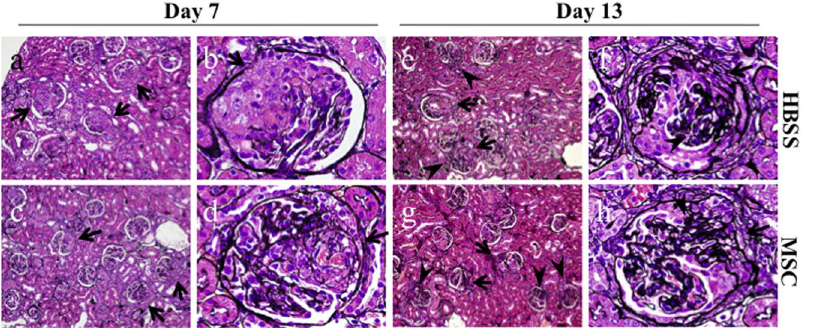
Figure 2. Light microscopic findings in the study groups. Representative pictures stained with silver on day 7 ( a – d ) and day 13 ( e – h ) in an HBSS-treated rat with nephritis ( a, b, e, f ) and an MSC-treated rat with nephritis ( c, d, g, h ). The glomeruli on day 7 show severe fibrinoid necrosis and cellular crescent formation (arrows) ( a, b ). The crescentic glomeruli have started to transform from cellular to fibrocellular (arrows), and there is some segmental glomerulosclerosis (arrowheads) on day 13 ( e, f ). hMSC treatment reduces glomerular hypertrophy on day 7 ( c, d ) and day 13 ( g, h ). hMSC treatment also reduces crescent formation on day 13 ( g, h ). Original magnifications, x200 (a, c, e, g), x1000 (b, d, f, h). doi:10.1371/journal.pone.0067475.g002 PLOS ONE |